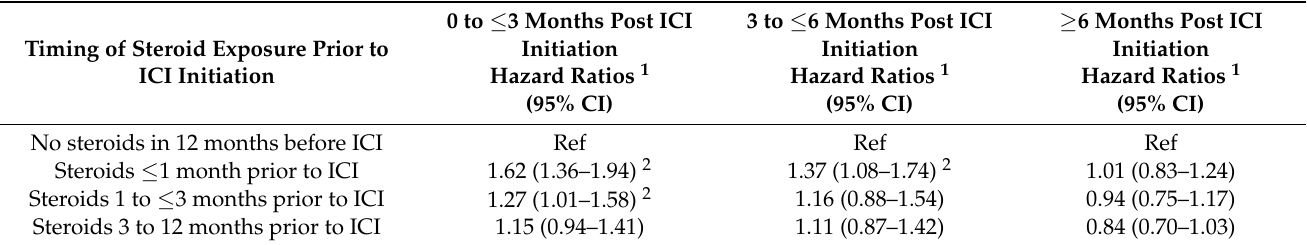
Figure 3. Time-dependent ER (panel a) and non-ER hospitalization (panel b) hazard ratios for all steroid-exposure groups and survival time periods. ( a ) Steroid exposure prior to ICI use is associated with higher ER hospitalization rates up to 6 months post ICI initiation. Steroid exposure up to 3 months prior is associated with higher ER hospitalization rates up to 6 months post ICI initiation. The elevated risk of ER hospitalization associated with prior steroid exposure diminished over time and vanished by 6 months post ICI. ( b ) For non-ER hospitalizations, steroid exposure 1 month prior is associated with higher non-ER hospitalizations up to 3 months post ICI initiation and steroid exposure 1–3 months prior is associated with higher non-ER hospitalization rates up to 6 months post ICI initiation. The elevated risk of non-ER hospitalization associated with prior steroid exposure diminished over time and vanished by 6 months post ICI. Table 3. Steroid-exposure timing prior to ICI initiation and its time-dependent association with ER hospitalization after ICI